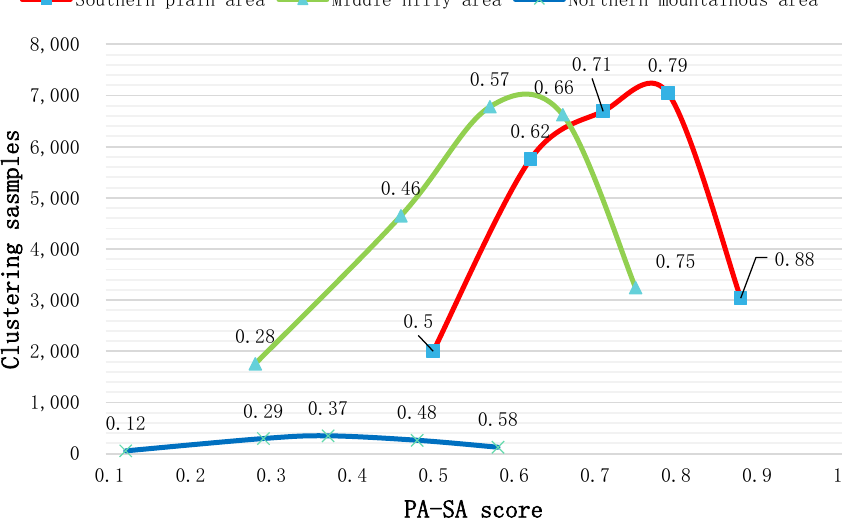
Figure 5. Clustering scores of the coupling coordination index of PA-SA.